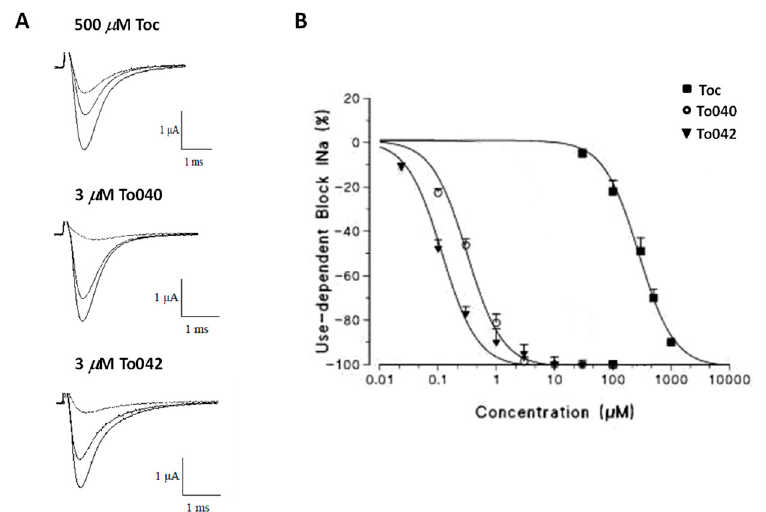
Figure 4. Tonic and use-dependent block exerted by Toc analogues (To040 and To042). ( A ) Traces of sodium current transients recorded in the absence and presence of the test compounds 500 μ M Toc, 3 μ M To040 and 3 μ M To042. ( B ) Concentration-response curves for 10-Hz use-dependent block of sodium currents obtained with Toc, To40 and To42 [96].